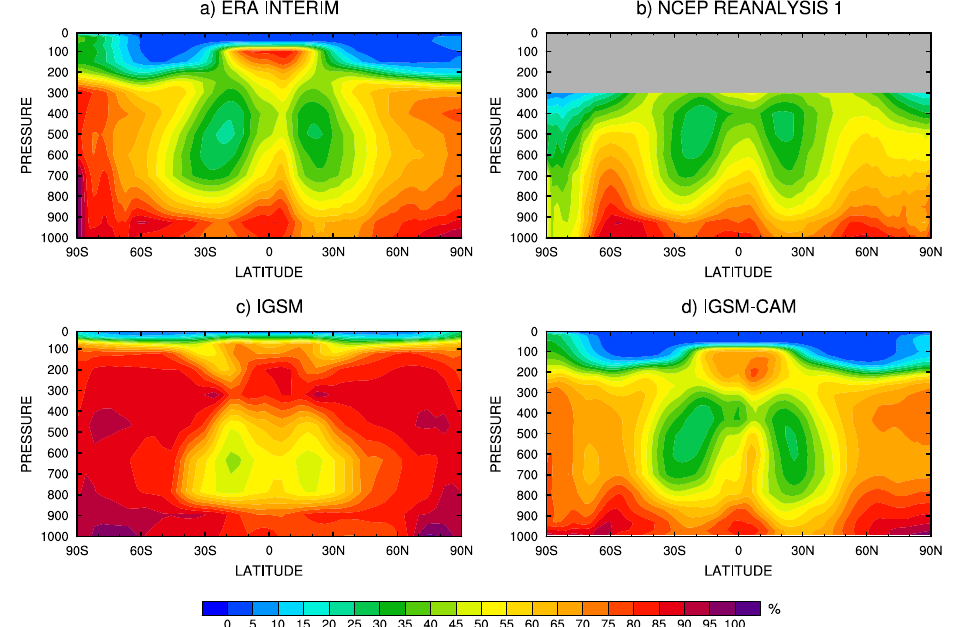
Fig. 5. Same as Fig. 4 but for relative humidity